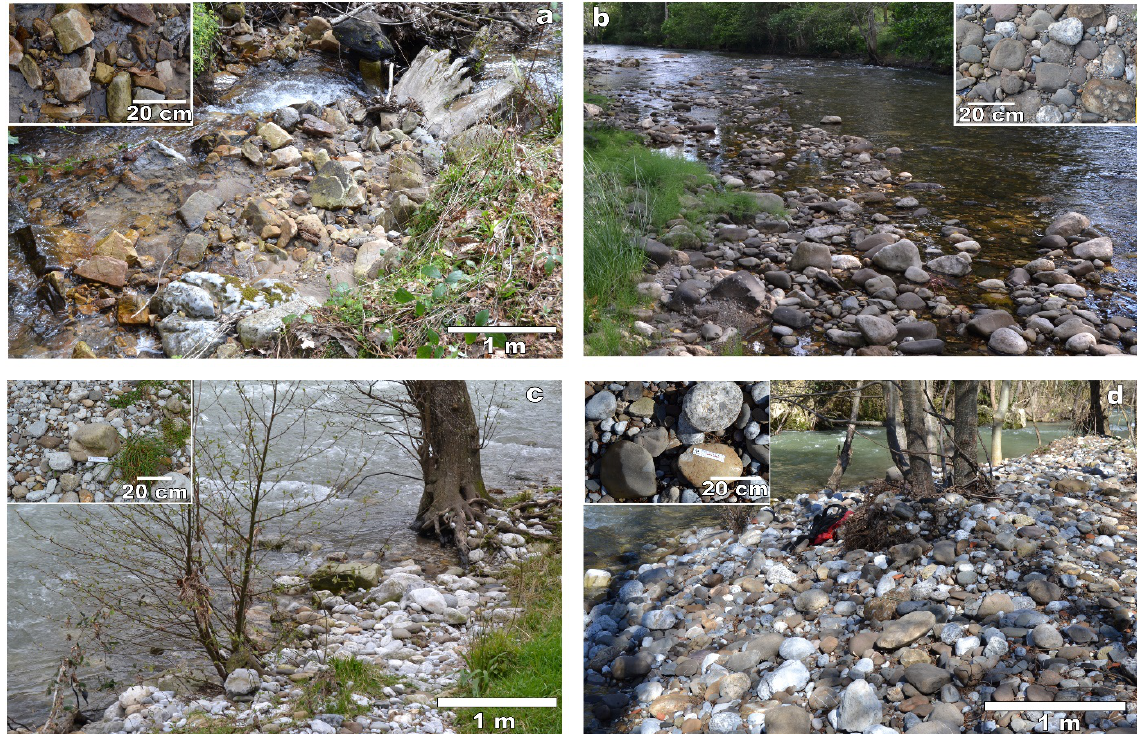
Figure 4. River beaches and banks from Deva and Cares Basin. A) La Candaliega Stream (high proportion of quartzarenites, as flatten, tabular pebbles or clasts). B) Deva beach river (quartzarenites, lutites and limestone as tabular, flatten or rounded pebbles, also a conglomerate fragment from the Campollo Group). C) Broader Deva beach river on the Lebeña bedrock (rounded, flatten and tabular pebbles made of limestones, quartzarenites and lutites). D) Small beach on the Devariver (Limestones and quartzarenites as tabular pebbles and